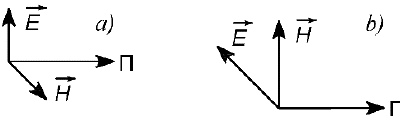
 Figure 4 – Pointing vector  is determined by: a) electrical and magnetic